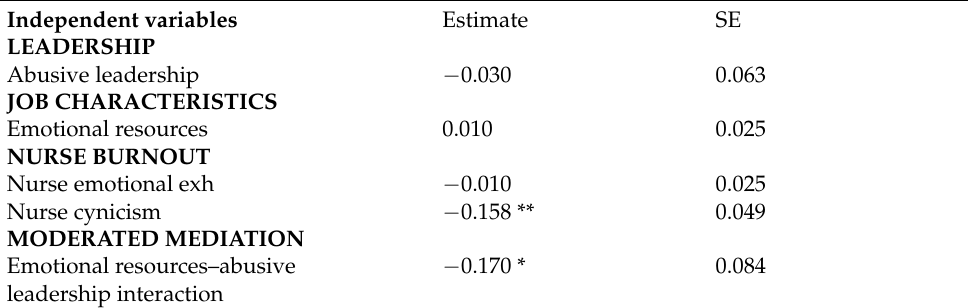
Table 3. Indirect effects on objective job performance.